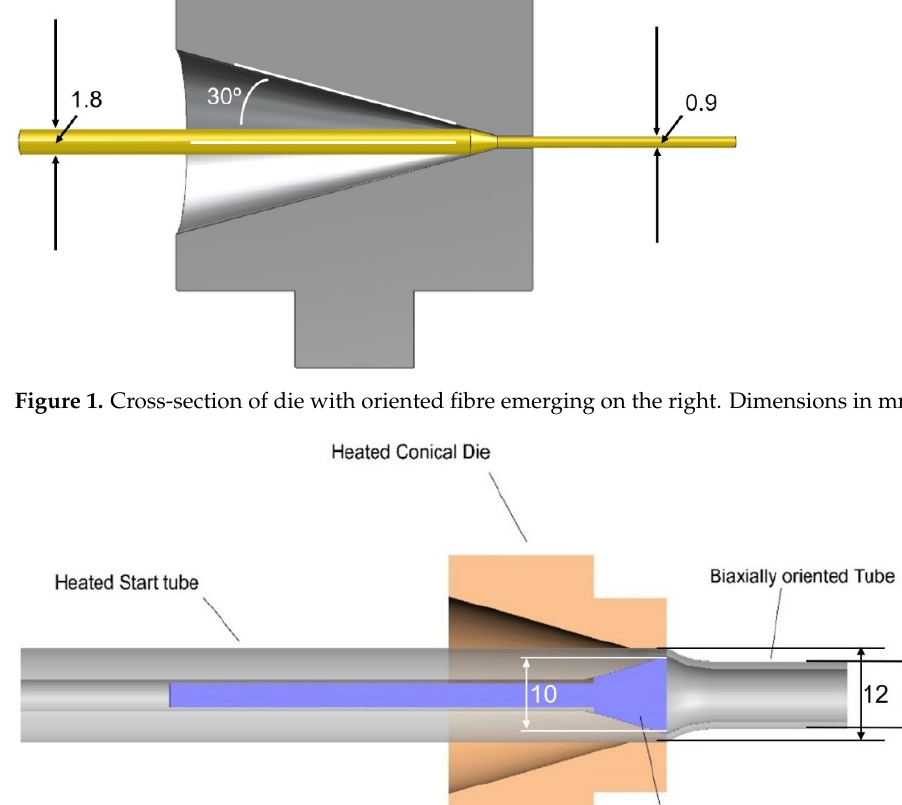
Figure 1. Cross ‐ section of die with oriented fibre emerging on the right. Dimensions in mm.